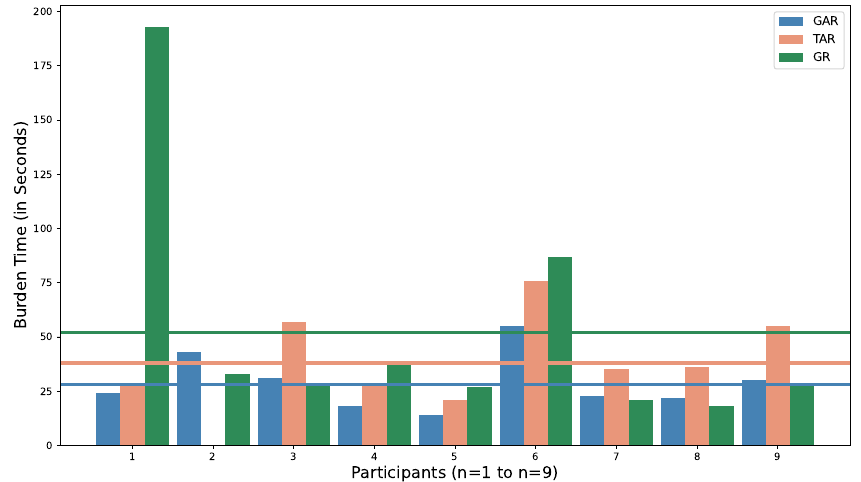
Figure 8. Average burden time of